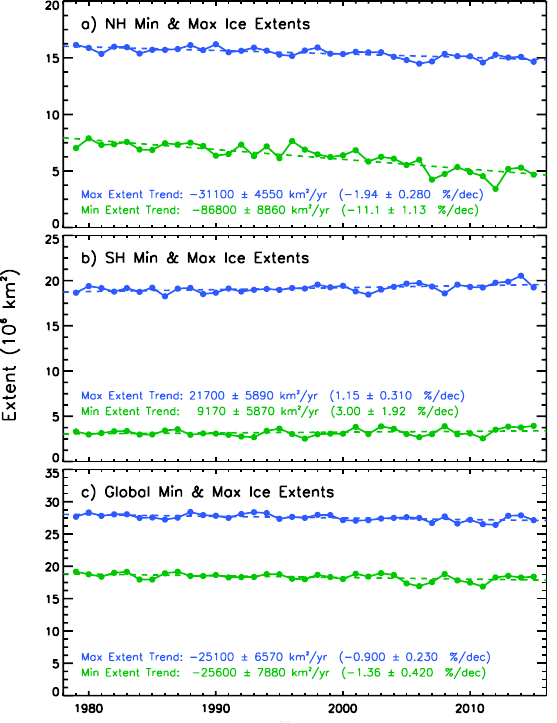
Figure 9. Yearly maximum and minimum extents of the sea ice cover in (a) the Arctic; (b) the Antarctic; and (c) the two hemispheres using a combined Arctic and Antarctic